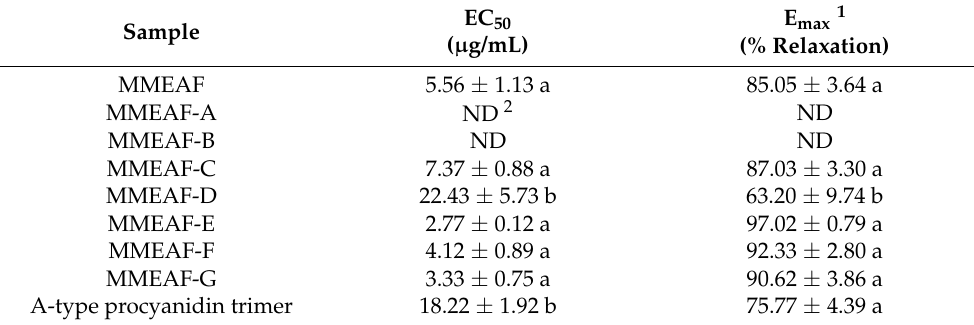
Figure 6. Concentration–response curves for subfractions ( A ) and A-type procyanidin trimer ( B ) in aortic rings with endothelium. Results are mean ± S.E.M of 4-7 experiments. Table 2. Half maximal effective concentration (EC 50 ) and maximal effect (E max ) of MMEAF, subfrac- tions and A-type procyanidin trimer for the vasodilator effect.